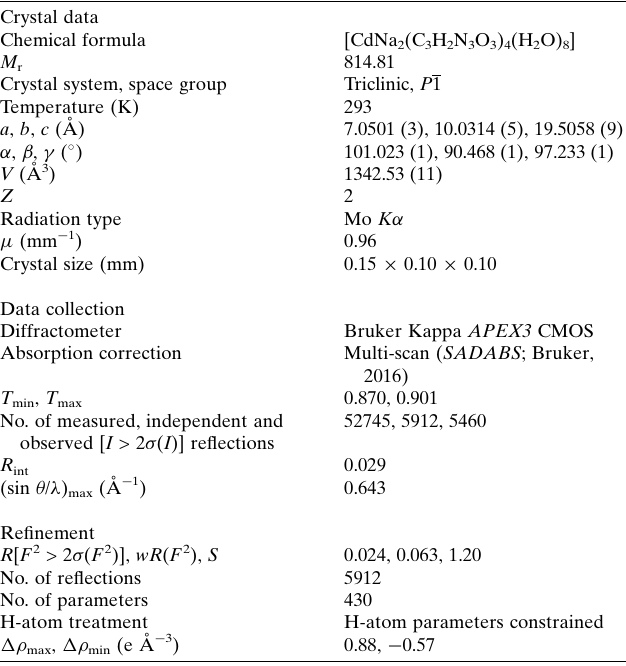
Table 4 Experimental details. Crystal data Chemical